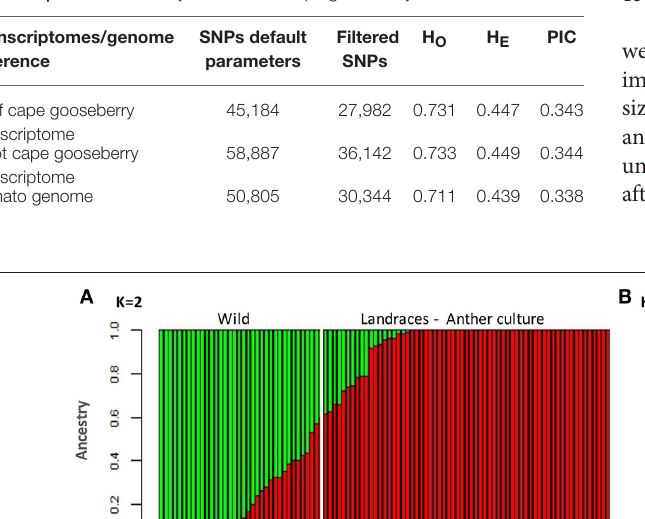
Frontiers in Plant Science |